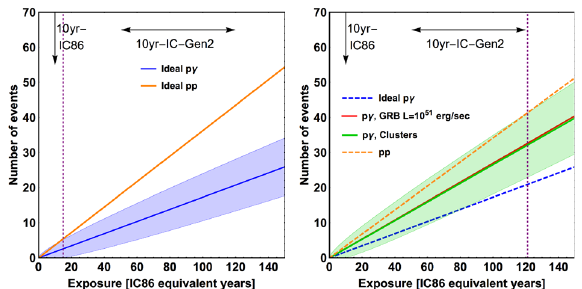
Figure 6. Expected number of Glashow resonance events over exposure time in IceCube (86 strings) in the ideal scenario (left) and in a more realistic scenario (right). The equivalent 10 year exposure time in IceCube-Gen2 is indicated by the arrow on the top of each panel. The bands represent statistical (Poissonian) uncertainties and uncertainties of the model (oscillation param- eters). The vertical dashed line shows the necessary exposure to discriminate between di ff erent source scenarios. Figure taken from